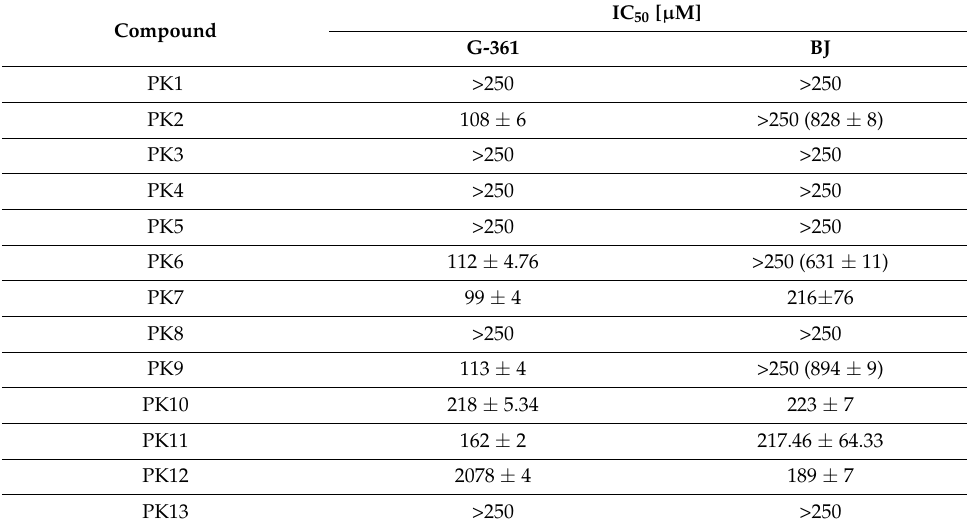
Table 4. IC 50 values obtained for the tested compounds based on MTT test results after 24 h treatment of G-361 melanoma and BJ normal fibroblast cell lines. The IC 50 value was determined using the AAT Bioquest IC 50